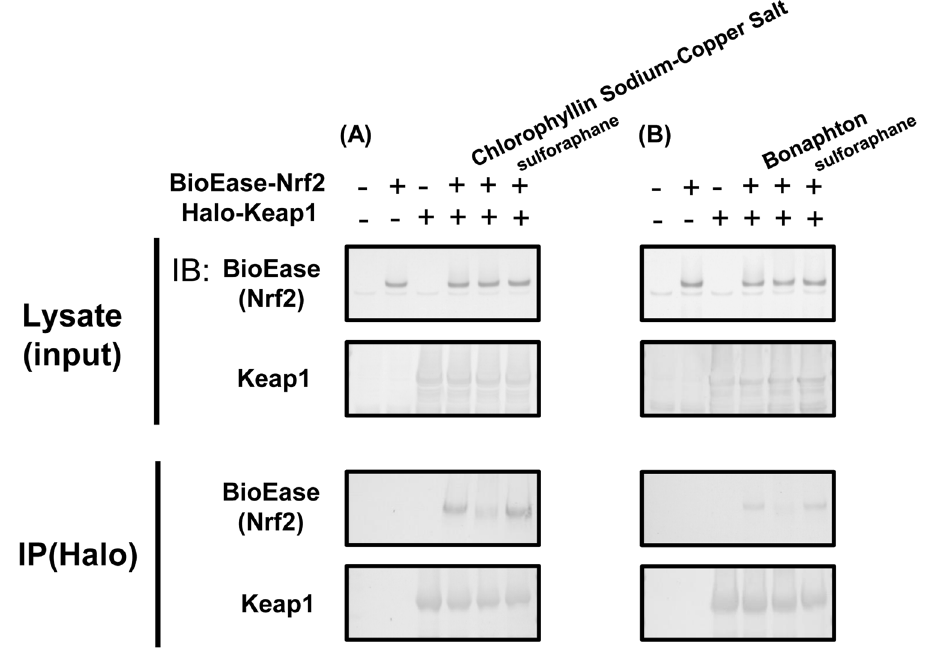
Figure 3. Effect of chlorophyllin sodium copper salt and bonaphton on binding of Keap1 to Nrf2. To clarify that ( A ) chlorophyllin sodium copper salt, and ( B ) bonaphton disrupt the interaction between Keap1 and Nrf2 by an alternative experiment other than FCS, we performed co-immunoprecipitation assay for the verification of disruption of Keap1 interaction by these compounds. BioEase-tagged Nrf2 was successfully immunoprecipitated by Halo-tagged Keap1, using Halo-antibody. Both of the compounds induced consistent decrease in binding between the two proteins, although protein-protein interaction between Keap1 and Nrf2 was not decreased by sulforaphane that does not disrupt interaction between Keap1 and Nrf2. This result indicated that these compounds inhibited the Keap1-Nrf2 protein-protein interactions directly. Experiments were repeated three times with consistent results, and a representative blot is shown. Full-length blots are presented in Supplementary Fig.